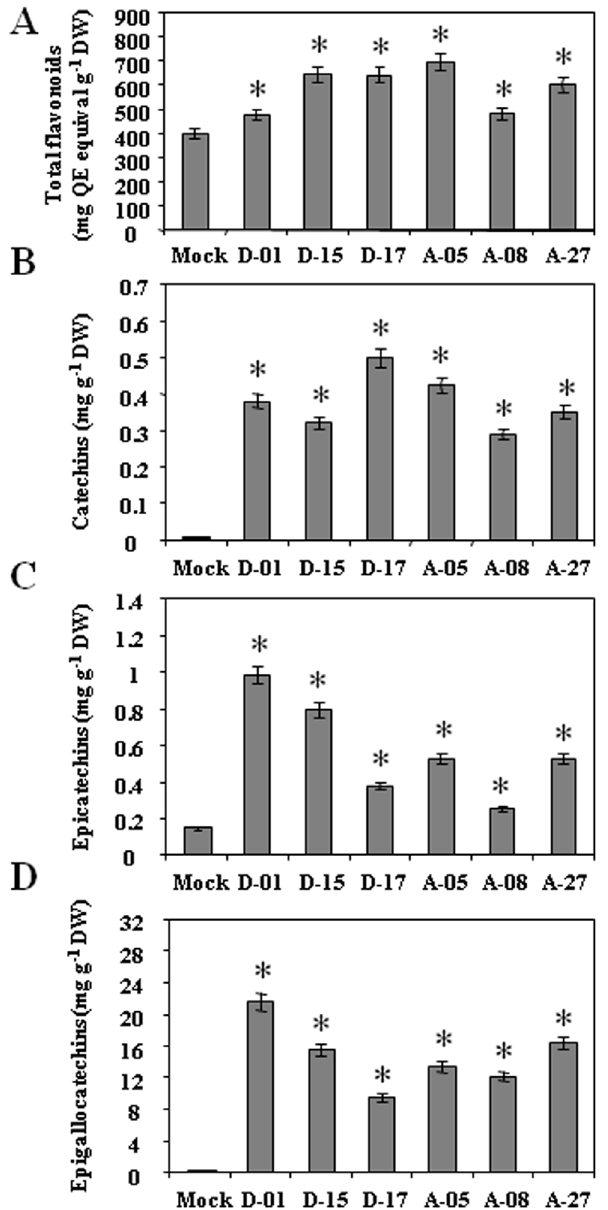
Figure 5. The CsDFR and CsANR overexpressing transgenic lines show higher contents of total flavonoids and increased flavan- 3-ols content in transgenic tobacco compared to control tobaccos. Three flavan-3-ols namely catechin, epicatechin and epigallocatechin were measured in CsDFR and CsANR transgenic lines vis-a`-vis control tobacco. Total flavonoids in CsDFR and CsANR overexpressing transgenic tobaccos (A). The catechin (B), epicatechin (C) and epigallocatechin (D) contents in CsDFR and CsANR transgenic lines as well as control tobacco plants. Data is the mean of three replications with error bars indicating 6 SD. Statistical significance is indicated as (*) for P , 0.05.